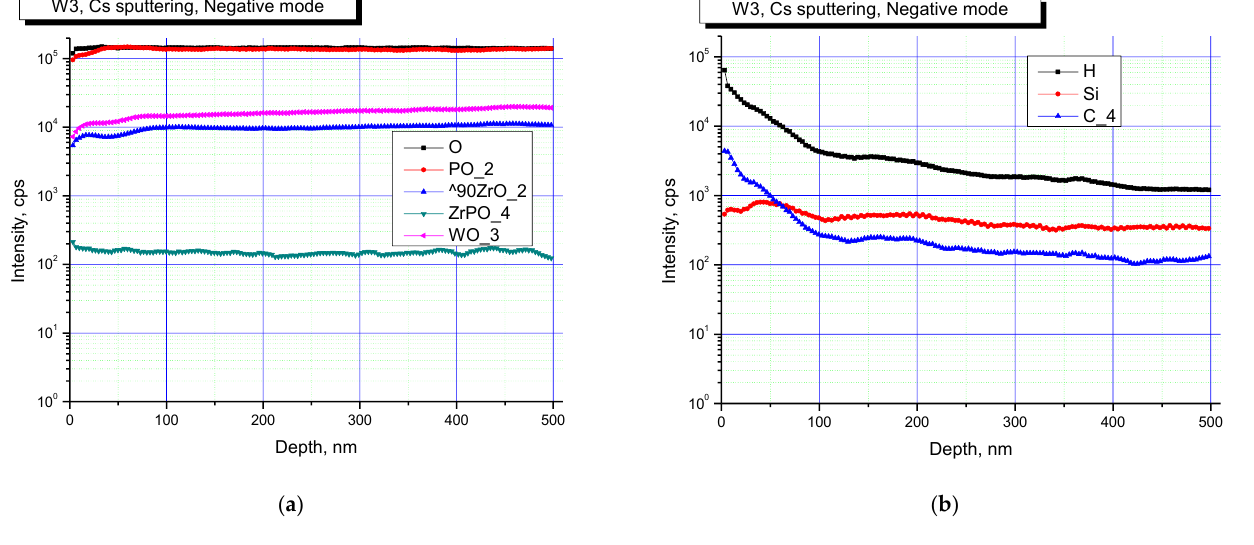
Figure 6. Profiles of main ( a ) and doping ( b ) elements on the surface of the irradiated Na 0.5 Zr 2 (PO 4 ) 2.5 (WO 4 ) 0.5 ceramics in negative secondary ion detection mode. Figures 7 and 8 show elemental profiles of the initial and irradiated Na 0.5 Zr 2 (PO 4 ) 2.5 (WO 4 ) 0.5 ceramic specimens in positive secondary ion detection mode.